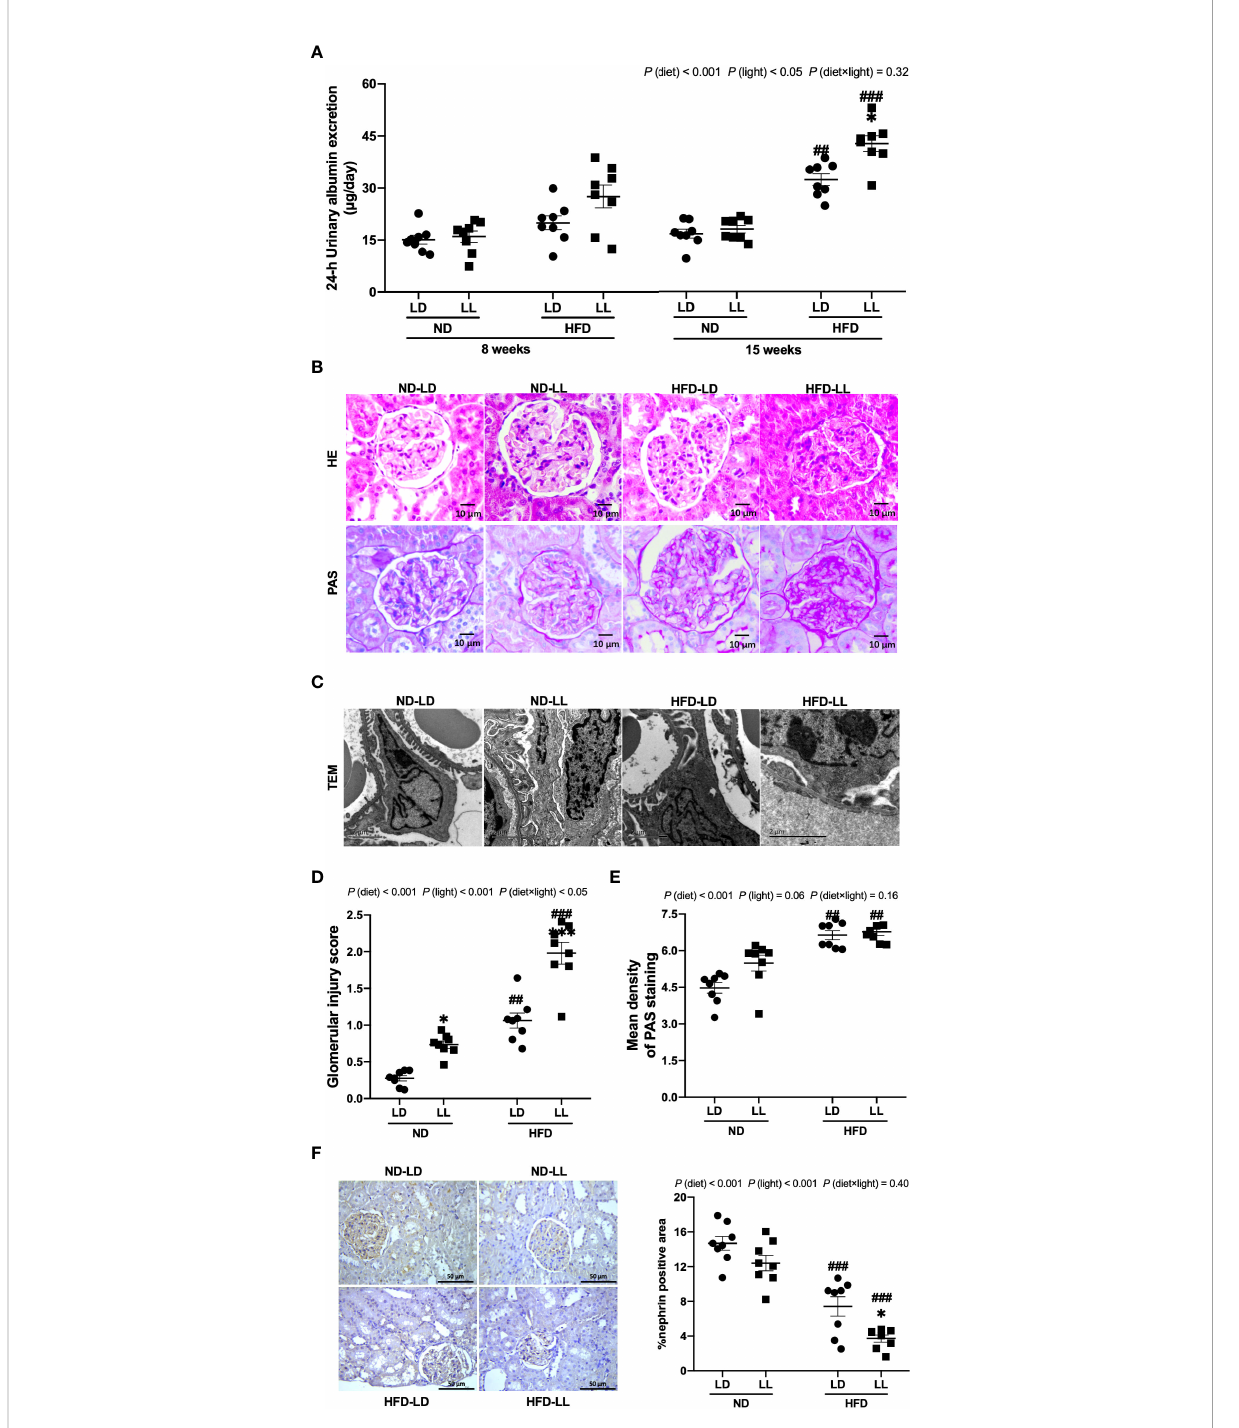
FIGURE 2 Effects of constant light exposure on urinary albumin exertion and glomerulopathy in rats. (A) 24-h urinary albumin excretion at 8 th and 15 th week of experiment in rats. (B) Representative images of HE staining and PAS staining of glomeruli (magni fi cation, 40×) as indicated. Scale bar=10 m m. (C) Representative transmission electron microscopic (TEM) images of glomeruli as indicated. Scale bar = 2 m m. (D) Glomerular injury scores. (E) Densitometric analyses of PAS staining. (F) Renal expression of nephrin by IHC and semi-quanti fi cation analysis. Values represent mean ± SEM (n=8 for A, D – F ). Differences were determined using a two-way ANOVA followed by a Bonferroni post hoc analysis. ## p <0.01, ### p <0.001, vs. ND counterpart. * p <0.05, ** p <0.01, vs. LD counterpart. p (diet), main effect of diet; p (light), main effect of light; p (light × diet), interaction effect of light and